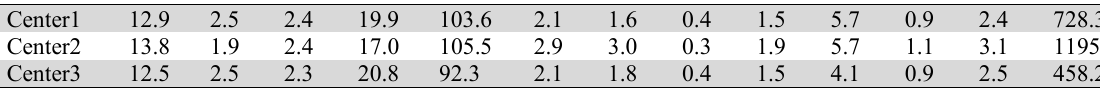
Centers obtained for the best OFV on wine data